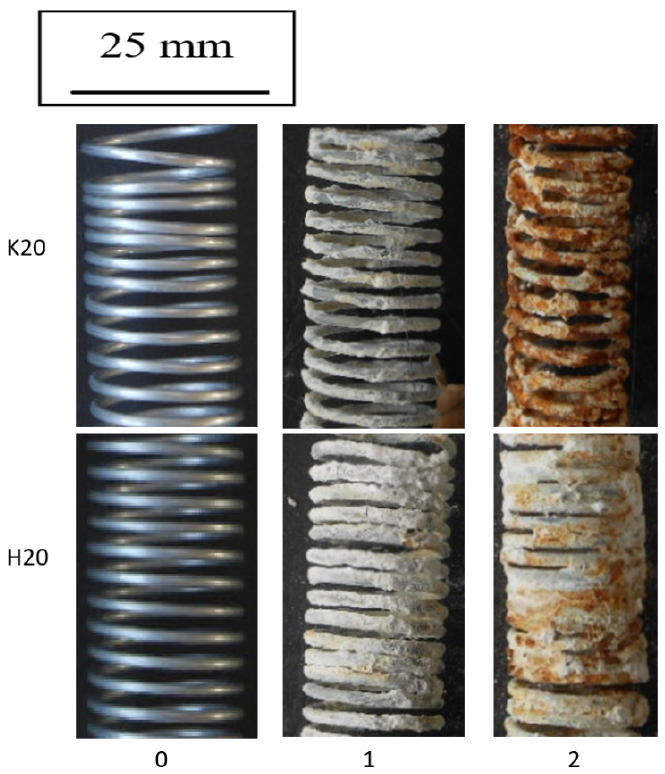
Figure 12. The surface appearance of the wires drawn at a speed of 20 m/s using the conventional K20 and hydrodynamic H20 method during corrosion tests in a salt chamber after two test cycles.